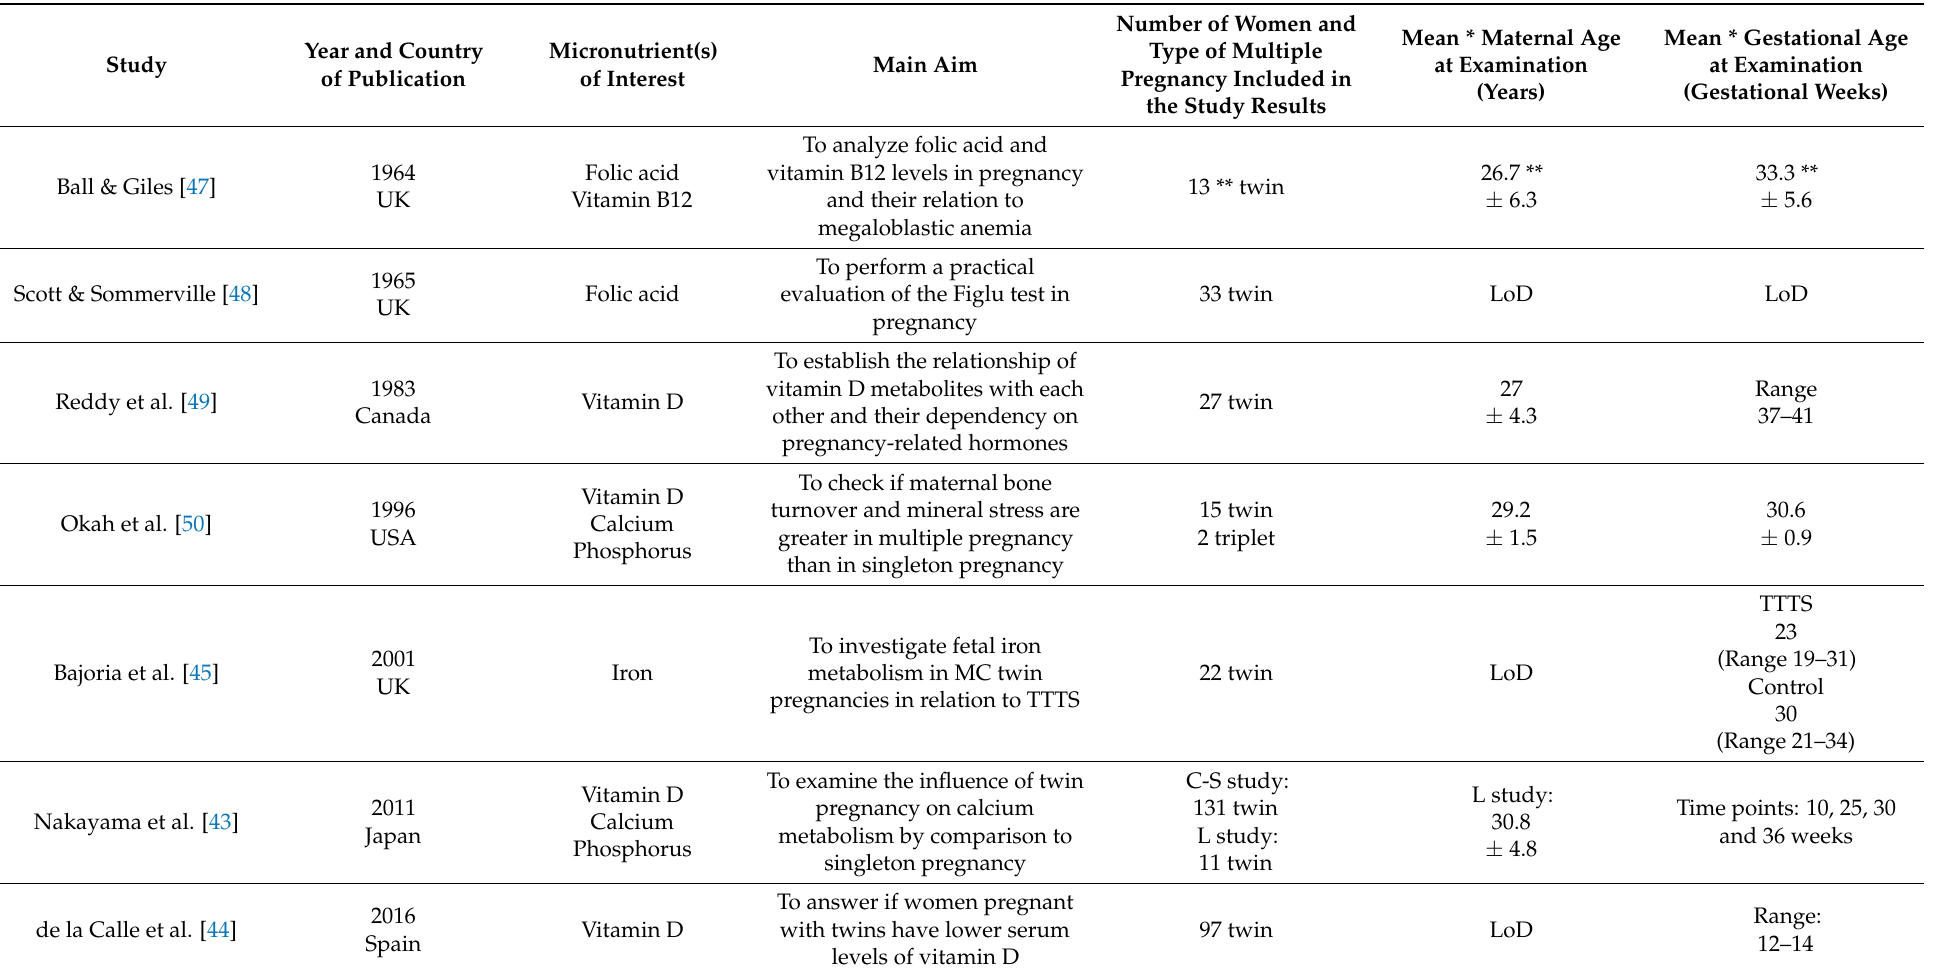
Table 3. The main characteristics of the retrieved